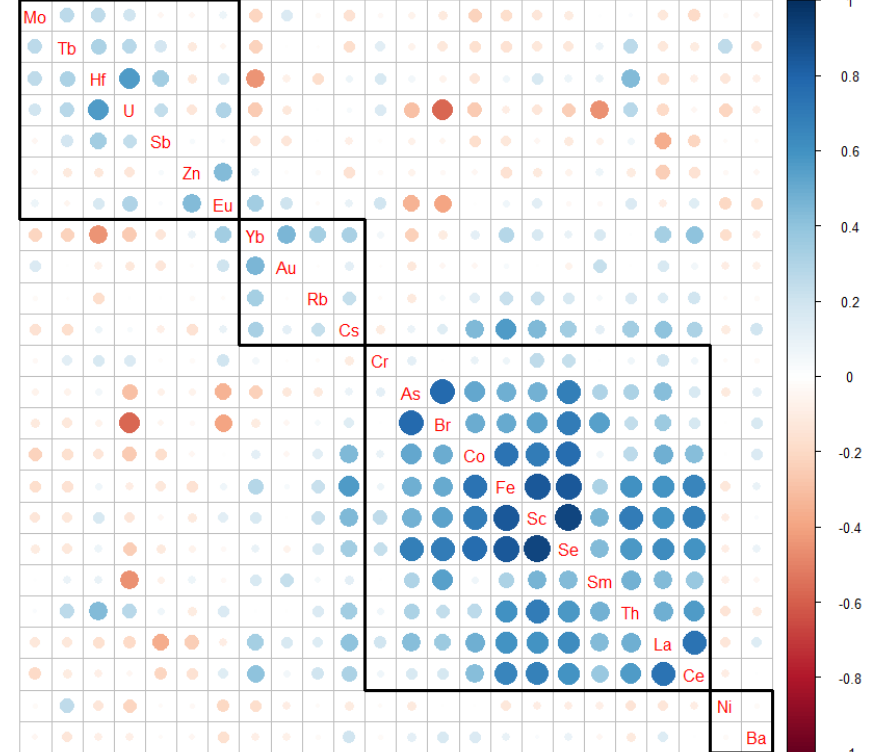
Figure 6. The correlation matrix of elements measured from the September filters.